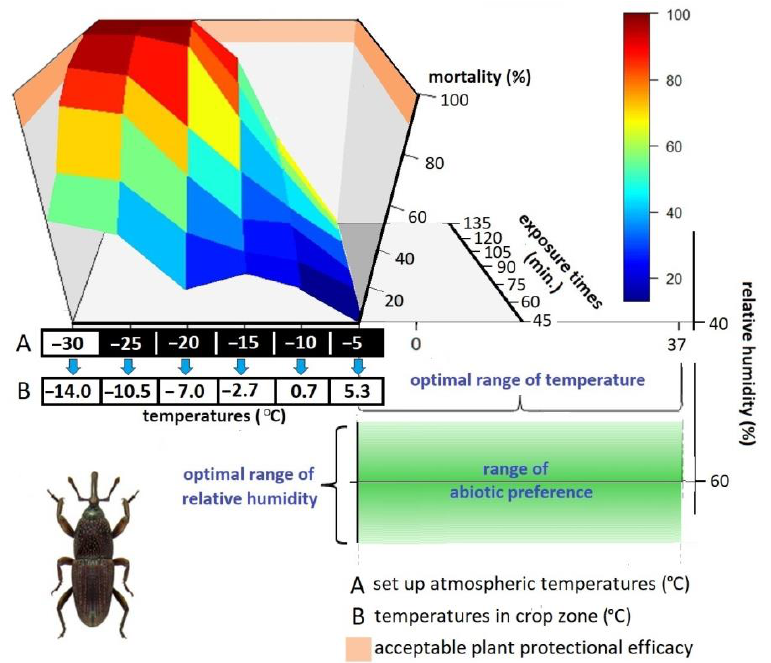
Figure 2. Extrapolation of the effect of set-up temperatures and their exposure times on the mortality of the granary weevil as a function of its ecological preference [25].